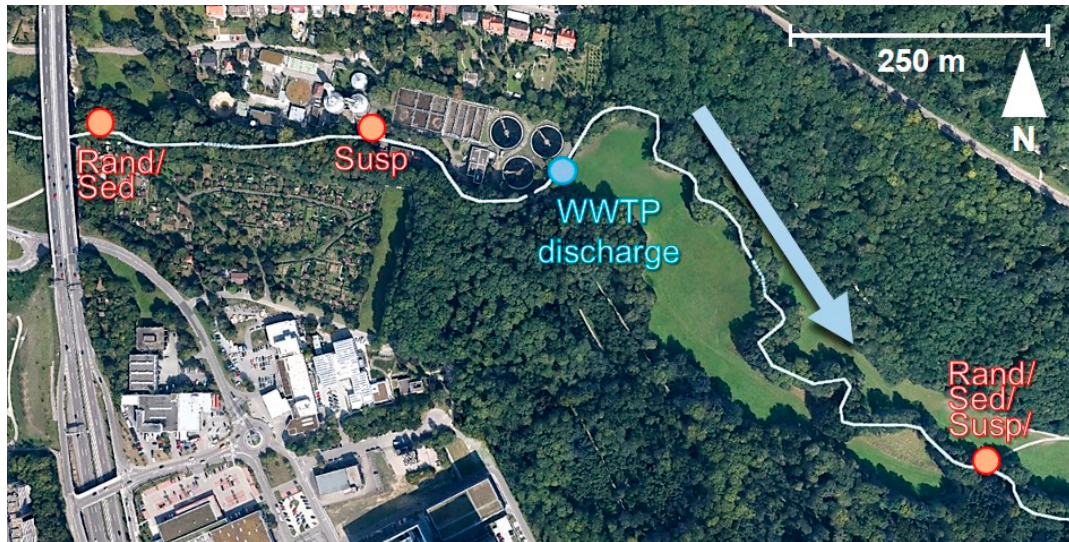
Figure A2. Sampling points of liquid random samples (Rand), suspended matter samples (Susp), and sediment samples (Sed) of River2 (Google Maps).